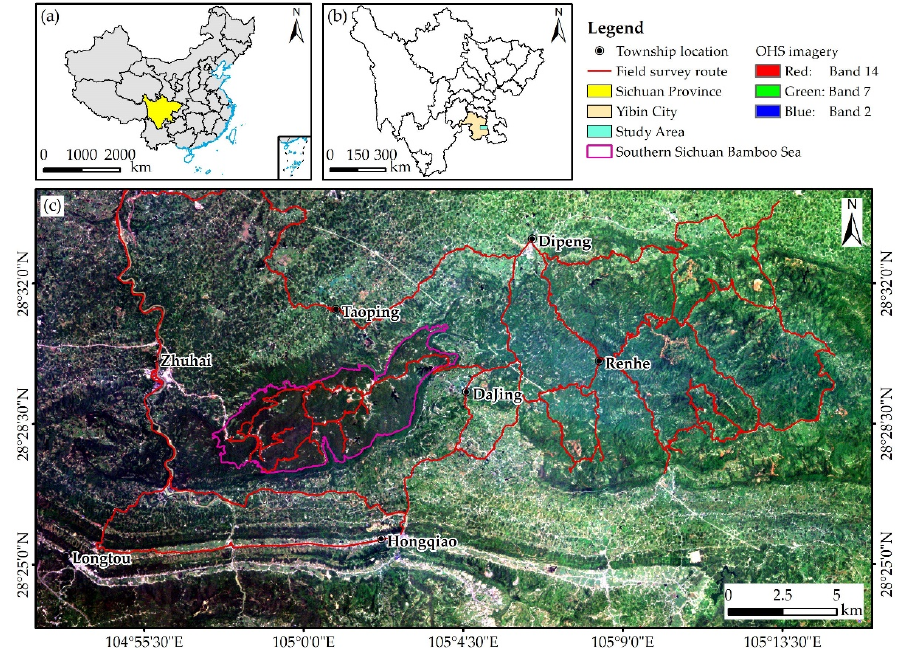
Figure 1. Location of the study area ( a – c ) and field survey route map ( c ). Table 1. OHS imagery and auxiliary data we used in this